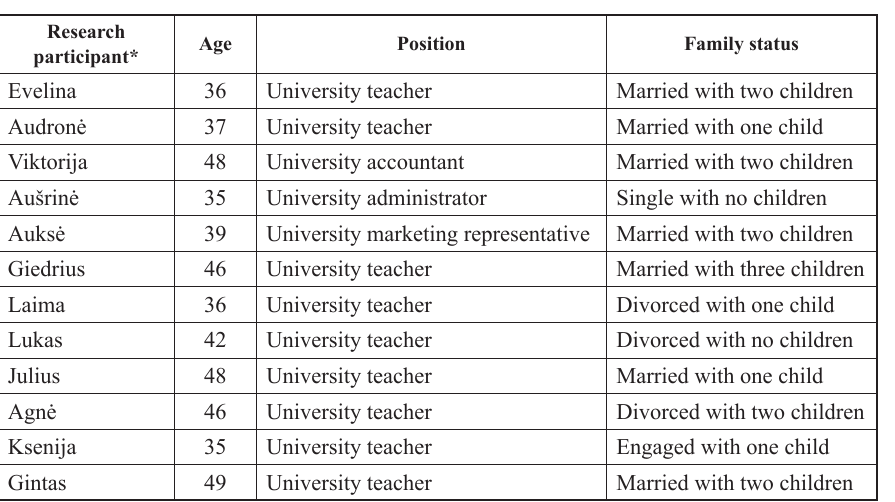
Table 1. Characteristics of